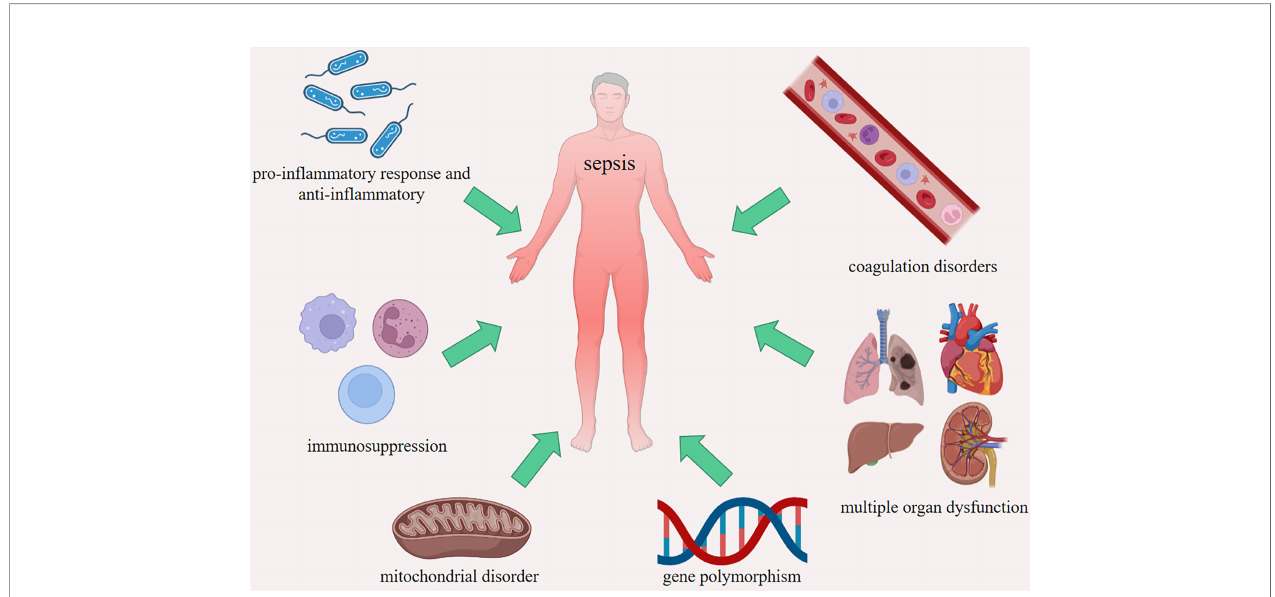
FIGURE 3 | The fundamental pathogenesis of sepsis. Imbalance between pro-in fl ammatory response and anti-in fl ammatory, coagulation disorders, immunosuppression, multiple organ dysfunction, mitochondrial disorder and gene